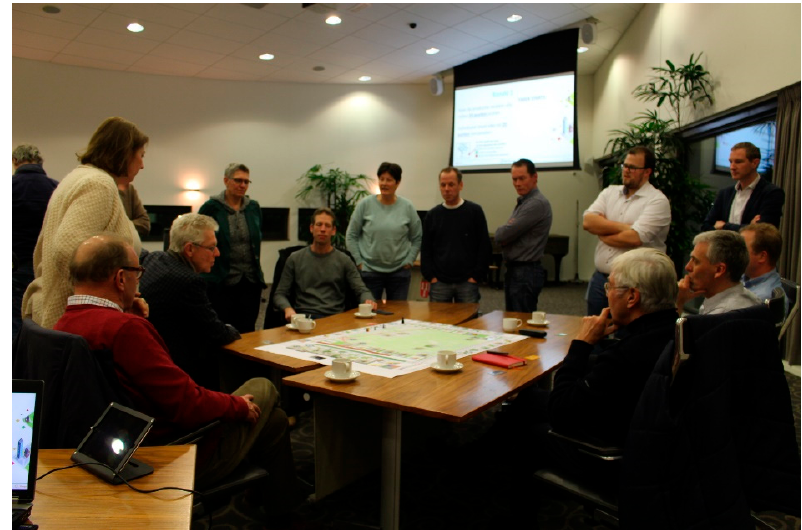
Figure 3. Game session held in one of the municipalities.